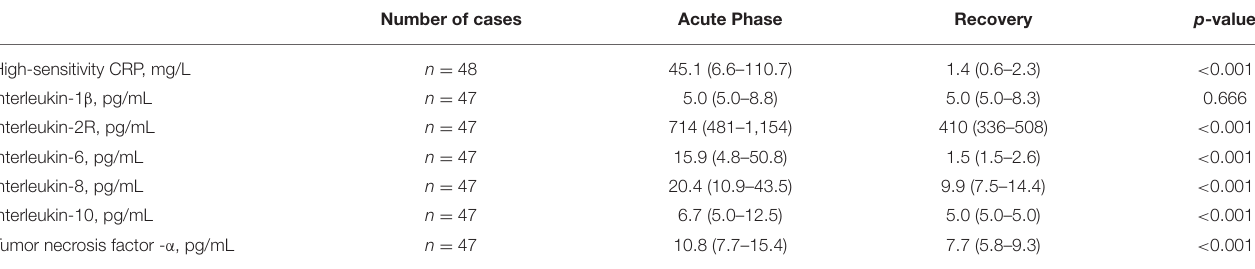
TABLE 2 | Comparisons of inflammatory biomarkers obtained at an acute phase and after